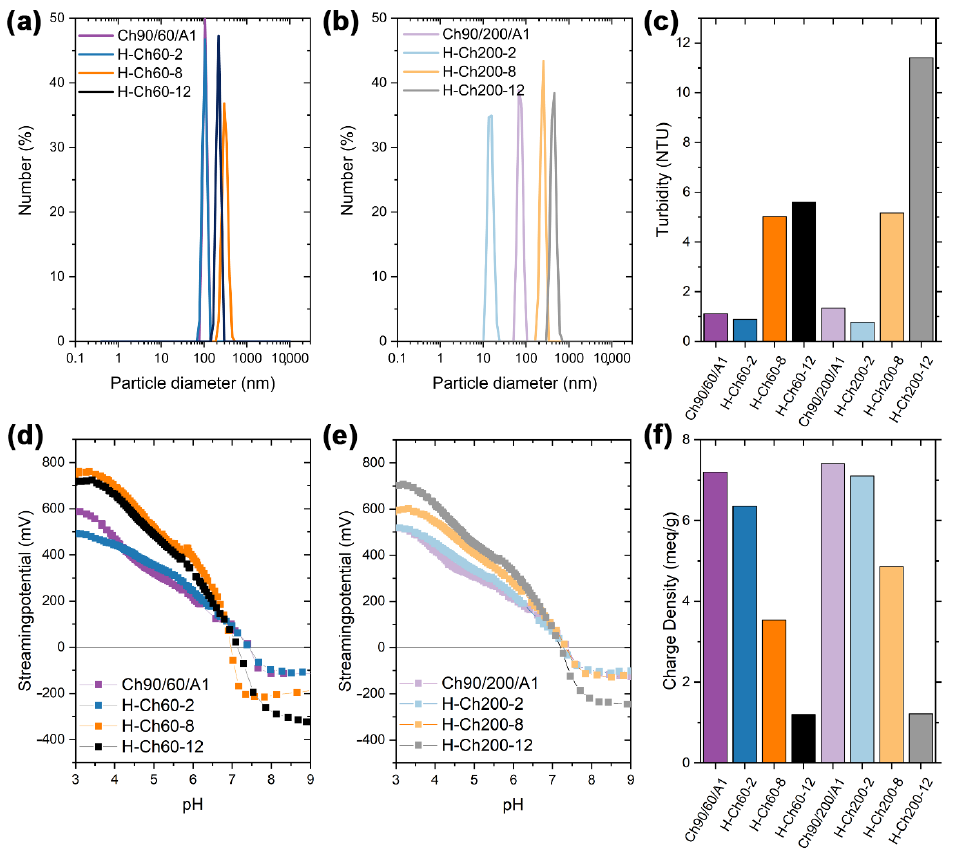
Ch60-2 also has the lowest DS%, leaving more amino functionalities for the adsorption pro- cess. Figure 2. ( a , b ) DLS, ( c ) turbidity, ( d , e ) streaming potential vs. pH, and ( f ) charge density measurements of Ch90/60/A1 and Ch90/200/A1, and the respective hexanoyl-modified derivatives. The streaming potential vs. pH curves for all of the samples featured similar curve progressions and an isoelectric point (IEP) at approximately pH 7 (Figure 2d,e, compare Section 2.5 and Table S2).